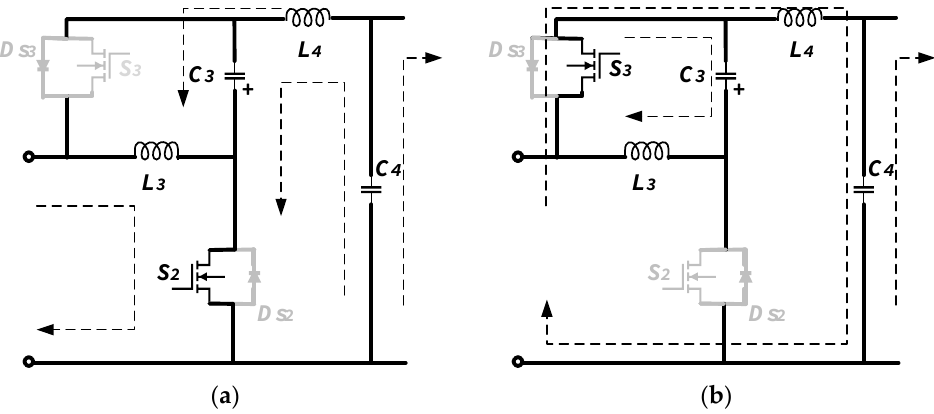
Figure 6. The state of the QZSI when the power switch ( a ) S 2 or ( b ) S 3 is activated.